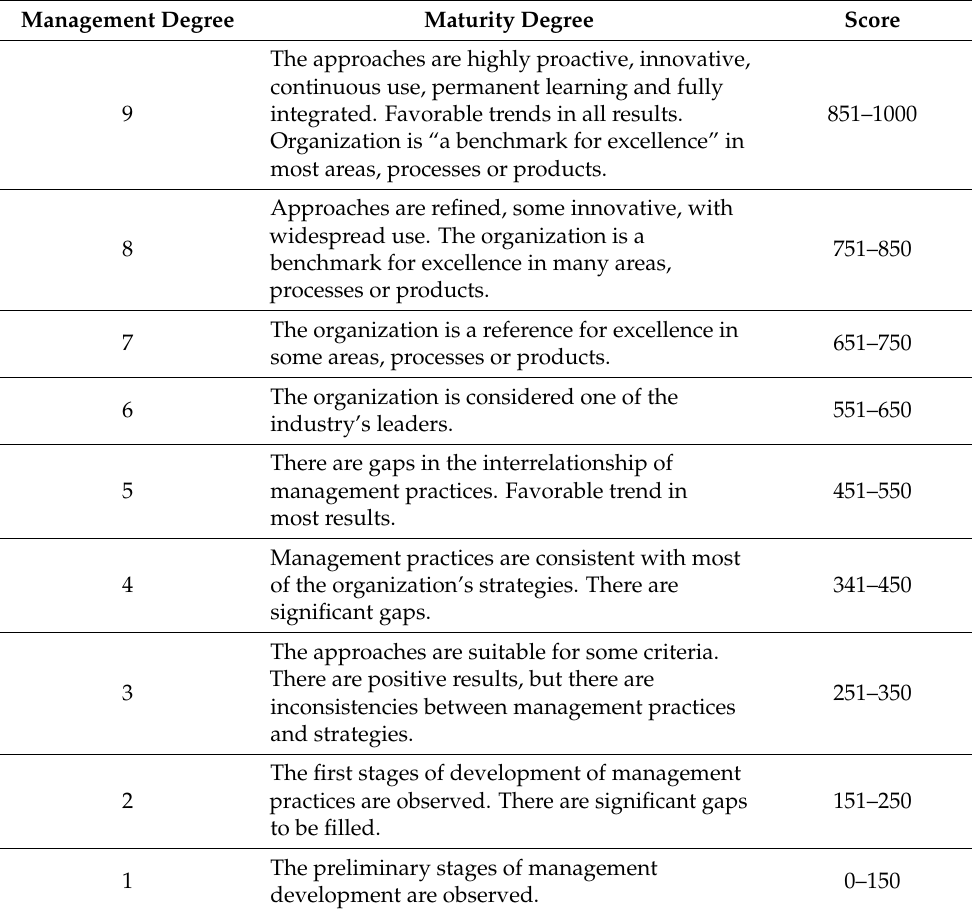
Table 2. Classification of the maturity level of